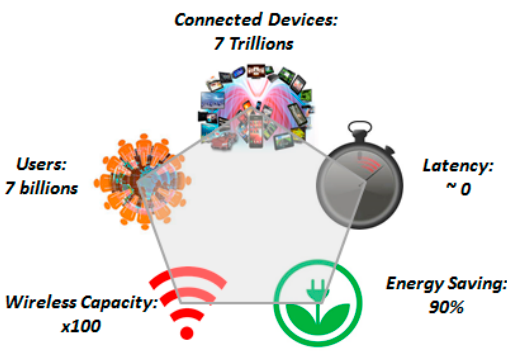
Figure 1. Design goals and requirements for 5G networks. (adapted from [3]).